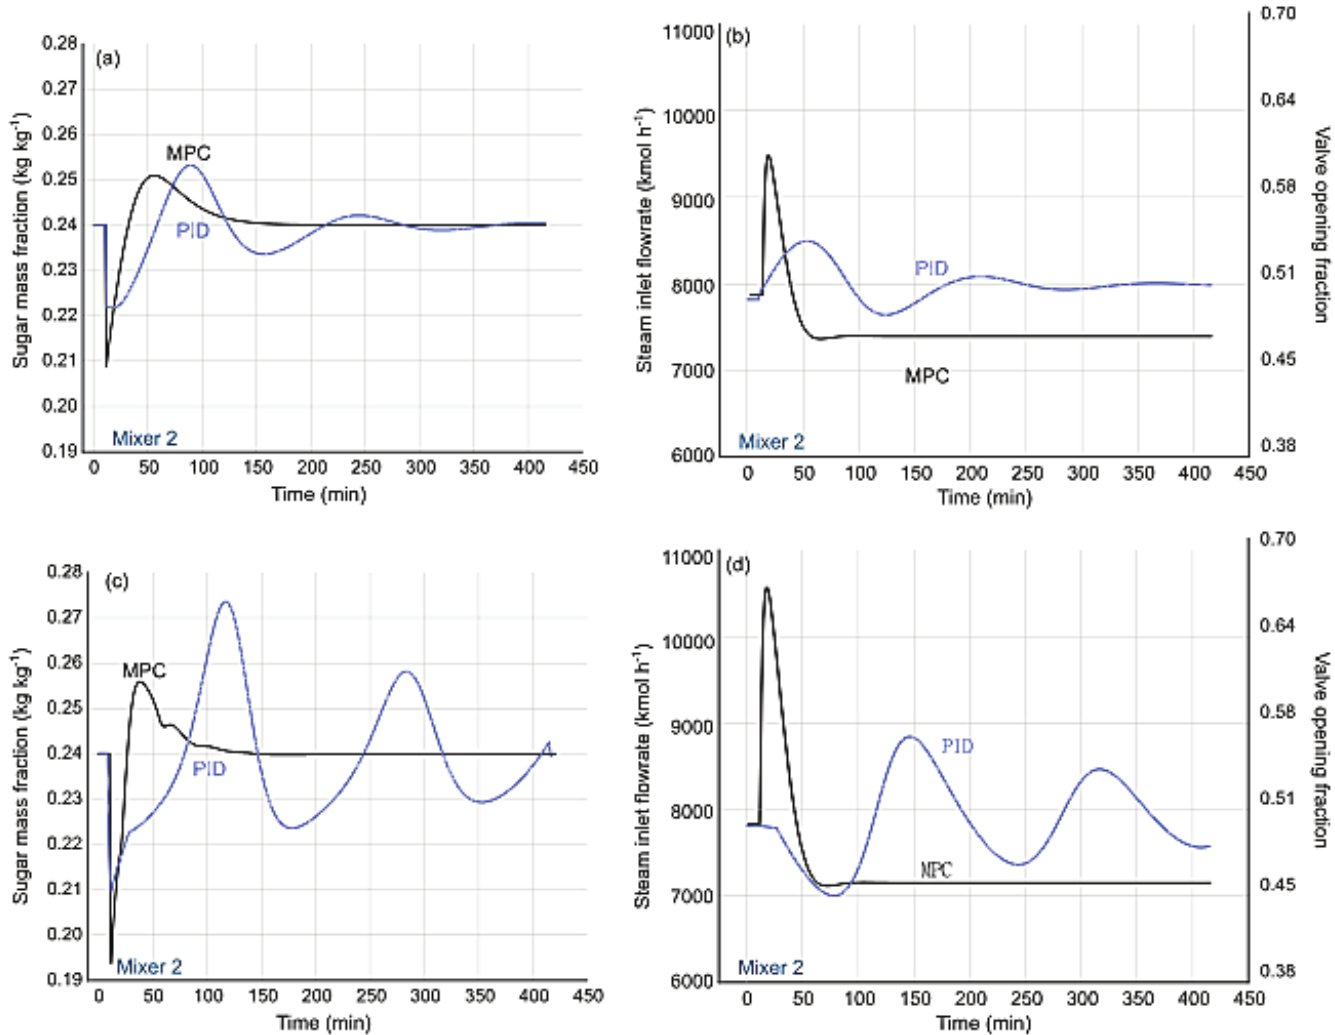
Fig. 8 – Responses of MPC and PID controlled concentration on the second mixer to a step disturbance in the glucose syrup volu- metric flow rate of –30 % (a) and –45 % (c), and behavior of the manipulated valve opening and steam inlet flow rate fed to the first evaporator (b) and (d) for –30 % and –45 %,